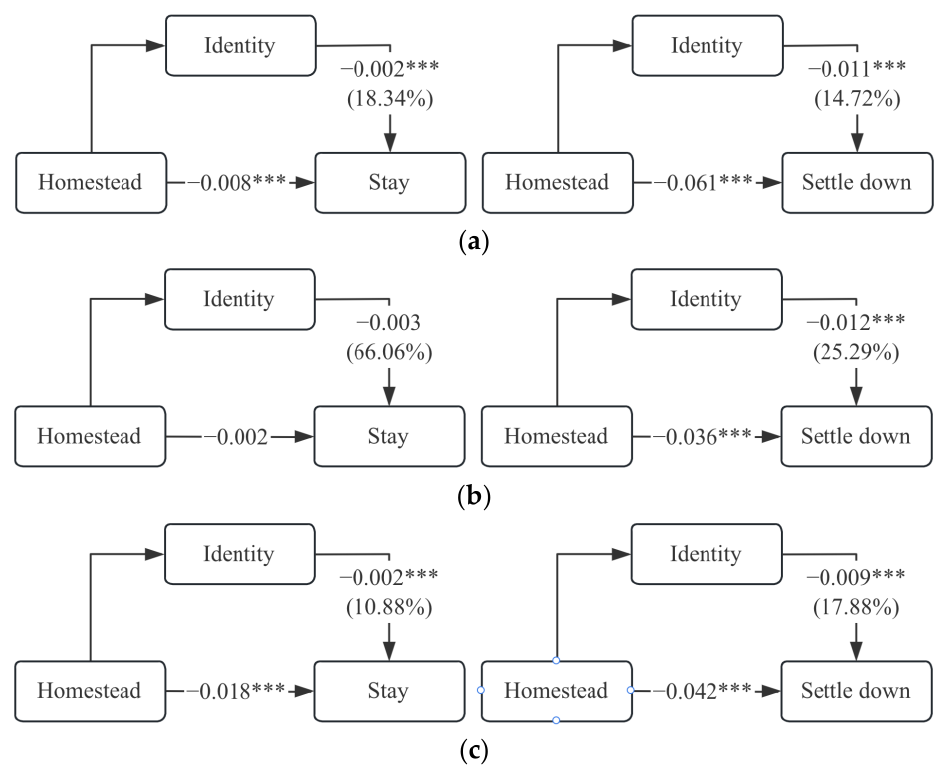
Figure 3. Mediating relationship by region. ( a ) Eastern region; ( b ) central region; ( c ) western region. *** p < 0.01, ** p < 0.05, * p <